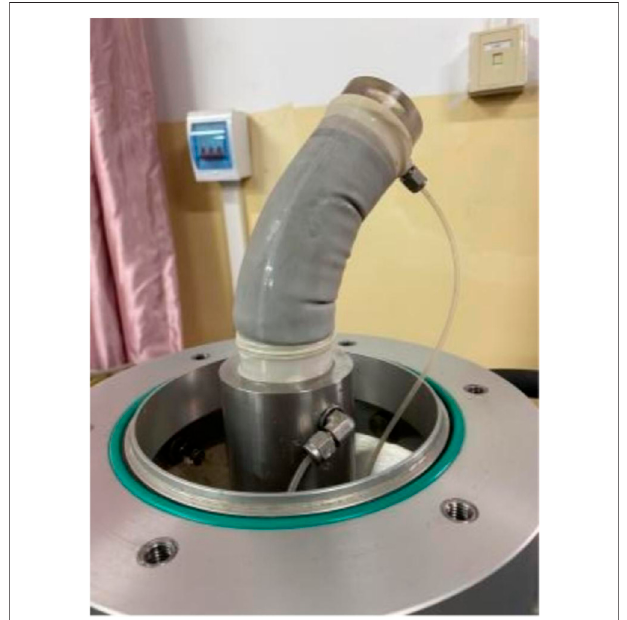
FIGURE 10 | Softening phenomenon of PG after liquefaction by bidirectional vibrations.